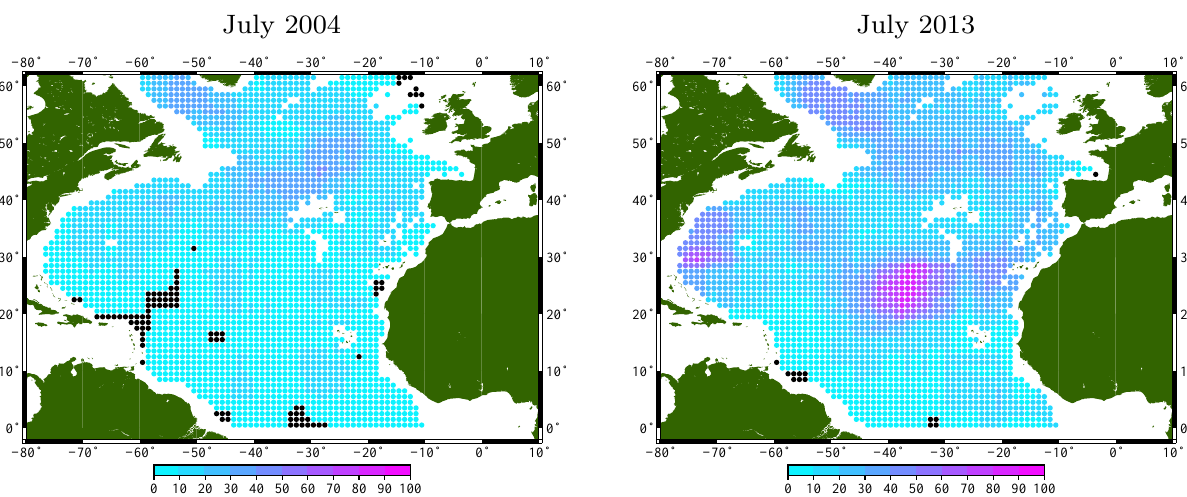
Figure 1. Number of Argo floats within a 10 × 10 ◦ box for grid cells where the depth is larger than 1000m. Only floats considered in this study are used for the statistics (Sect. 3.2). The black dots indicate no floats in the 10 × 10 ◦